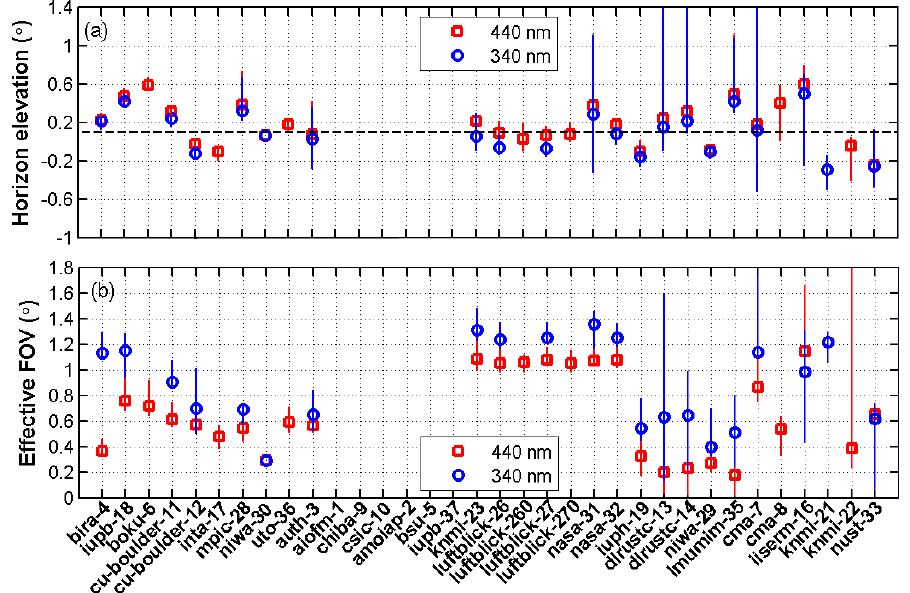
Figure 6. Summary of the average horizon elevation (a) and of the field of view (b) , resulting from the horizon scans performed at 340 and 440nm. Symbols represent median values and the vertical bars 10th and 90th